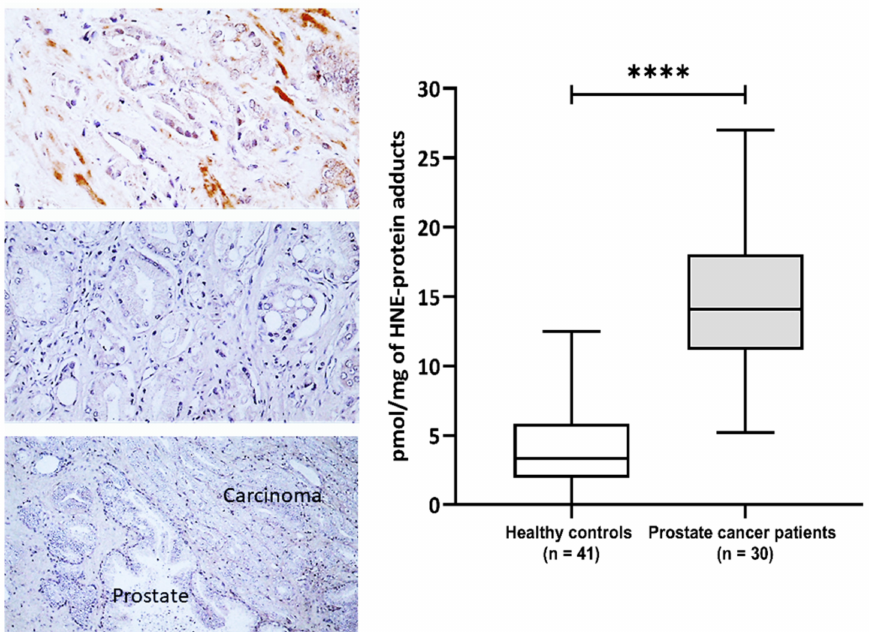
Figure 1. The 4-hydroxynonenal (4-HNE) modification of plasma and prostate cancer tissue pro- teins. Left—Immunohistochemistry of prostate carcinoma specimens obtained by monoclonal anti- body specific for the 4-HNE-protein adducts visualized the 4-HNE presence by brown color (DAB staining), while negative cells were contrast-stained blue by hematoxylin. Photo on the top shows rare immunopositivity of the stromal cells observed only for one patient/cancer (200 × ), the middle photo shows the most usually observed absence of 4-HNE in cancer and in stromal cells (200 × ), while the lower photo shows the absence of 4-HNE both in cancer and in the adjacent prostate tissue (100 × ). Right—Plasma concentration of 4-HNE–protein adducts (pmol/mg of protein) in samples of healthy controls ( n = 41) and prostate cancer patients ( n = 30). Results are presented as a box and whisker plot. The line in the box represents the median, while the interquartile range (IQR) box represents the middle quartiles (the 75th minus the 25th percentile). The whiskers on either side of the IQR box represent the lowest and highest quartiles of the data. The ends of the whiskers represent the maximum and minimum of the data. **** p <